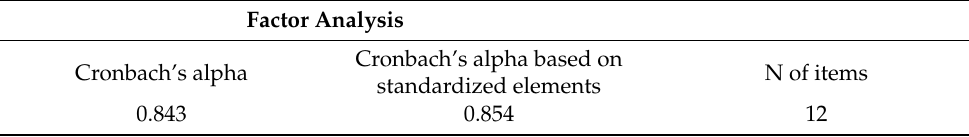
Table 4. Cronbach’s alpha calculation of the first dimension.